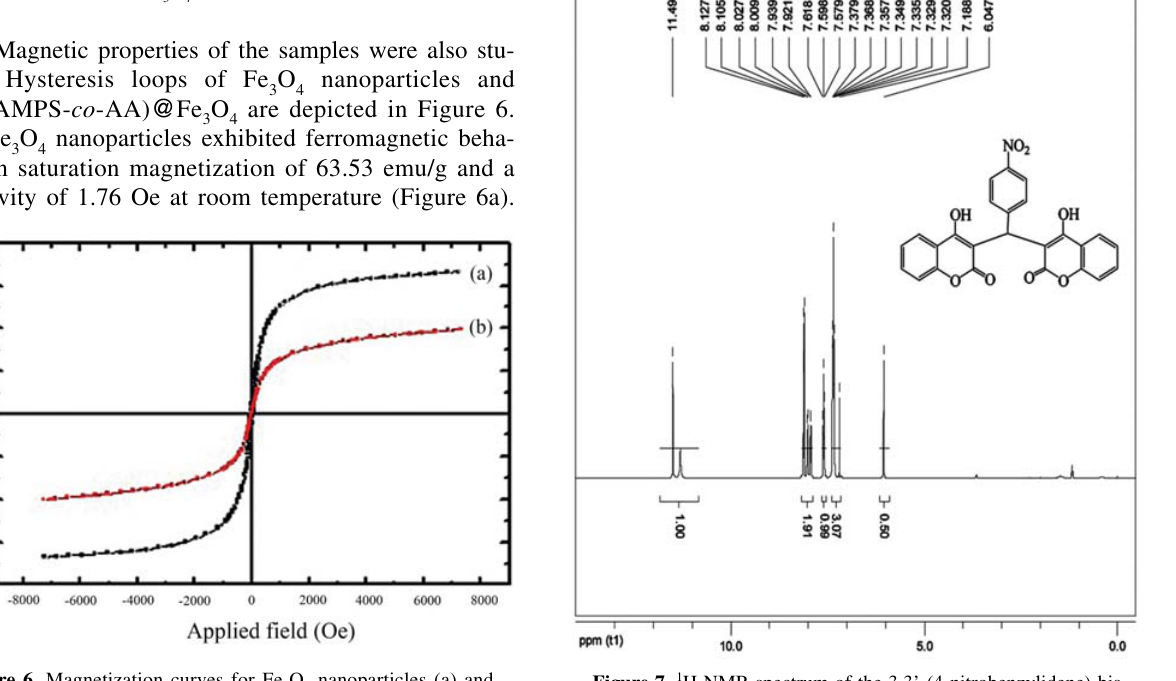
Figure 5. The XRD patterns of Fe poly(AMPS- co -AA) @ Fe